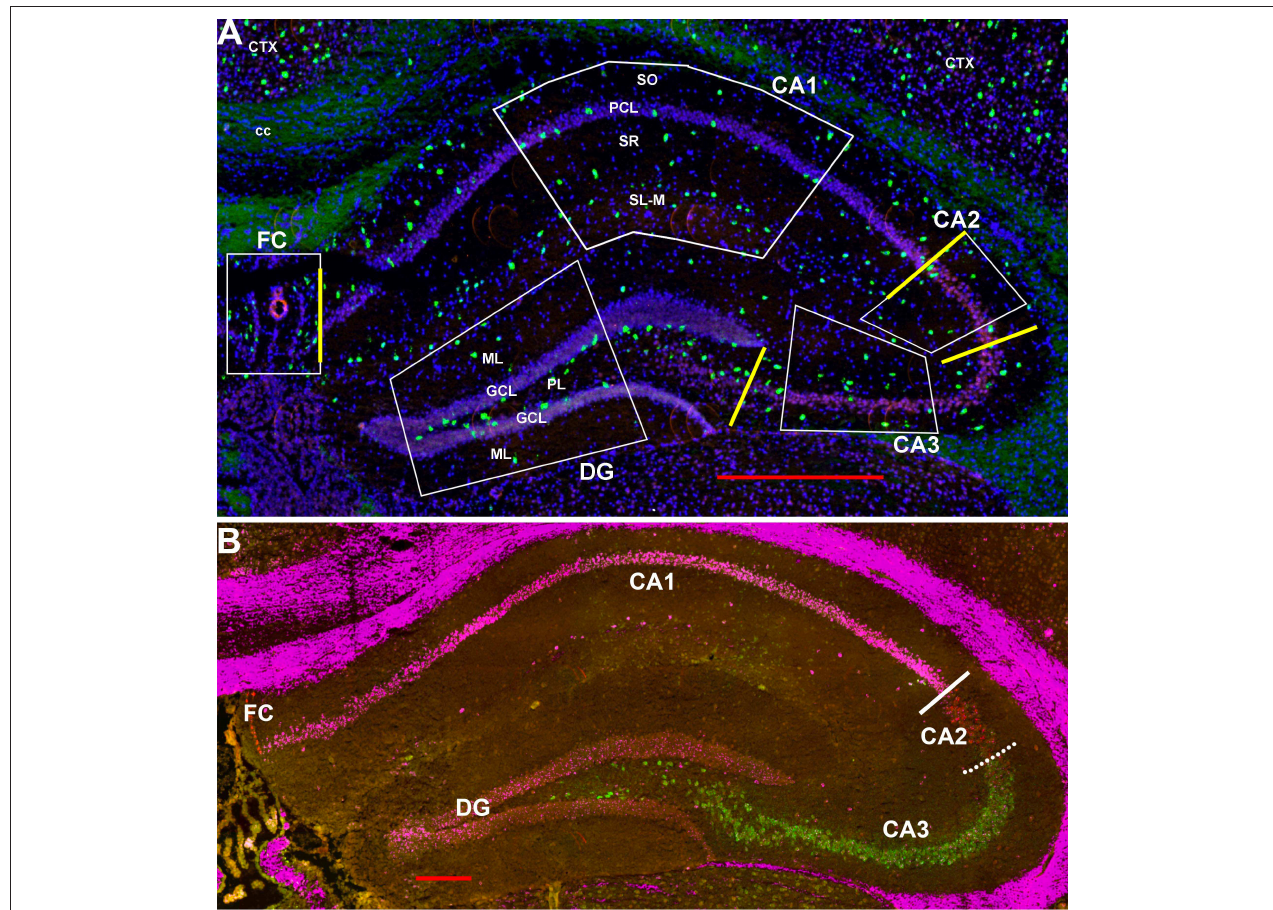
FIGURE 1 | (A) Representative areas in which interneurons were counted at 1.8mm behind the bregma showing Gad-1 cells. CA1-4, cornu ammonis 1–4 regions; cc, corpus callosum; Ctx, neocortex; DF, dentate gyrus; FC, fasciola cinereum; GCL, granule cell layer; PCL, pyramidal cell layer; PL, polymorphic layer (hilus); SL-M, stratum lacunosum-moleculaire; SO, stratum oriens; SR, stratum radiatum. Yellow bars indicate the boundaries used between FC, CA1, CA2, CA3, and DG to calculate region lengths for Figure 9 . Bar is 500 µ m. (B) Similar section probed for Trpc4 in CA1 (magenta), Amigo2 in CA2 (red), and Bok in CA3 (green) to show the CA1-CA2 and CA2-CA3 boundaries. Whereas, the former boundary is fairly strict, there is considerable mixing of CA2 and CA3 cell types at that “border.” Bar is 200 µ m.